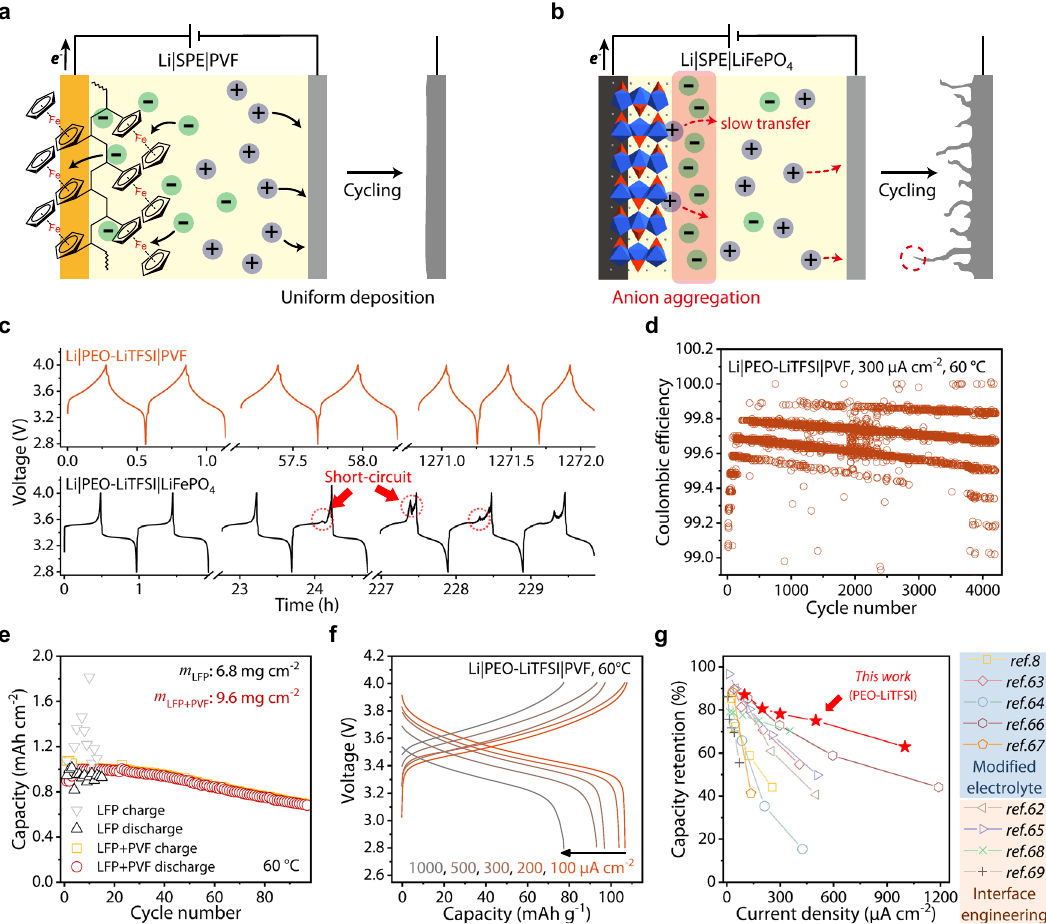
Fig. 5 Electrochemical energy storage tests for lithium metal cells using the PEO-LiTFSI solid electrolyte. Schematic diagram of anode morphology changes during cycling where ( a ) PVF and ( b ) LiFePO 4 served as cathode. c The potential pro fi les of Li||PVF (top) and Li||LiFePO 4 (bottom) cells at 300 μ A cm − 2 , 60 °C. d Coulombic ef fi ciency of Li||PVF cell over 4000 cycles at 300 μ A cm − 2 , 60 °C. e Cycles with LiFePO 4 and mixed cathode (LiFePO 4 :PVF = 1:1) at high areal loading. f The potential pro fi les of Li||PVF cells from 100 to 1000 μ A cm − 2 and ( g ) the comparison between this work and the other reported advanced SPEs, classi fi ed in the graph by design strategy (detail seen in Supplementary Table